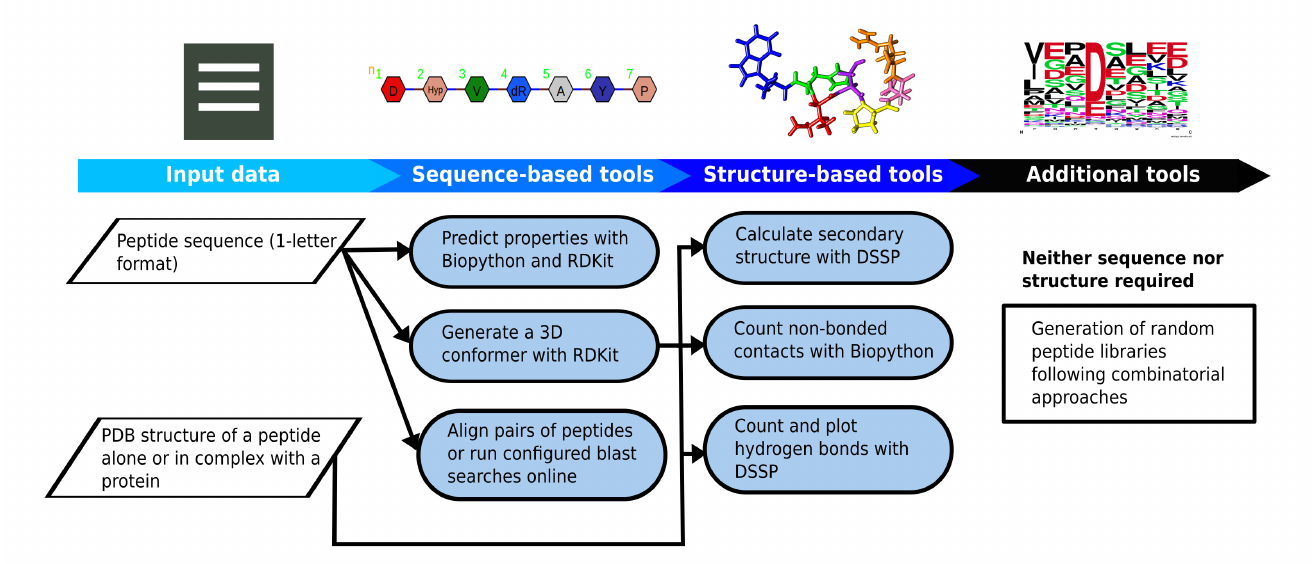
Figure 5. Flowchart of the PepFun repository based on the sequence, structure and additional tools provided to analyze massive datasets of